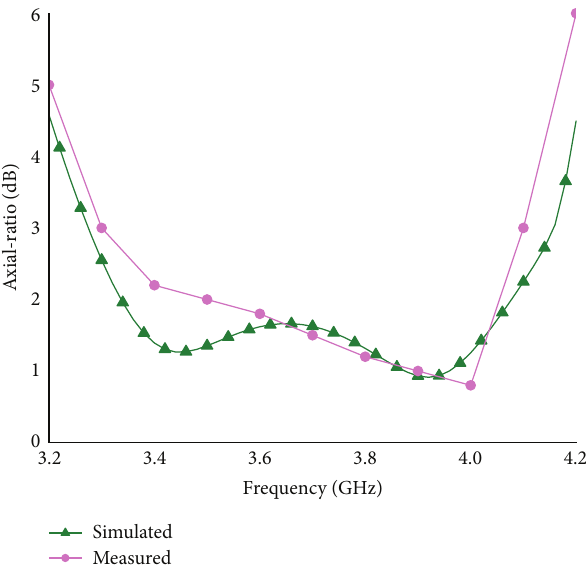
Figure 11: Gain of the antenna versus frequency.